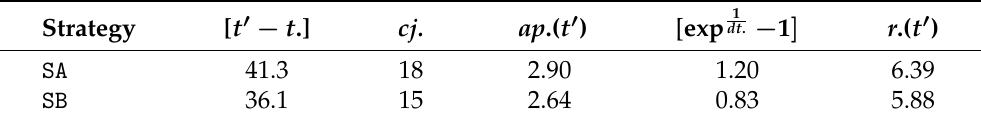
Table 8. Comparison of the monthly risk level of the SA and SB strategies of the SWL. The values are expressed as a monthly average, August 2020 for SA and August 2021 for